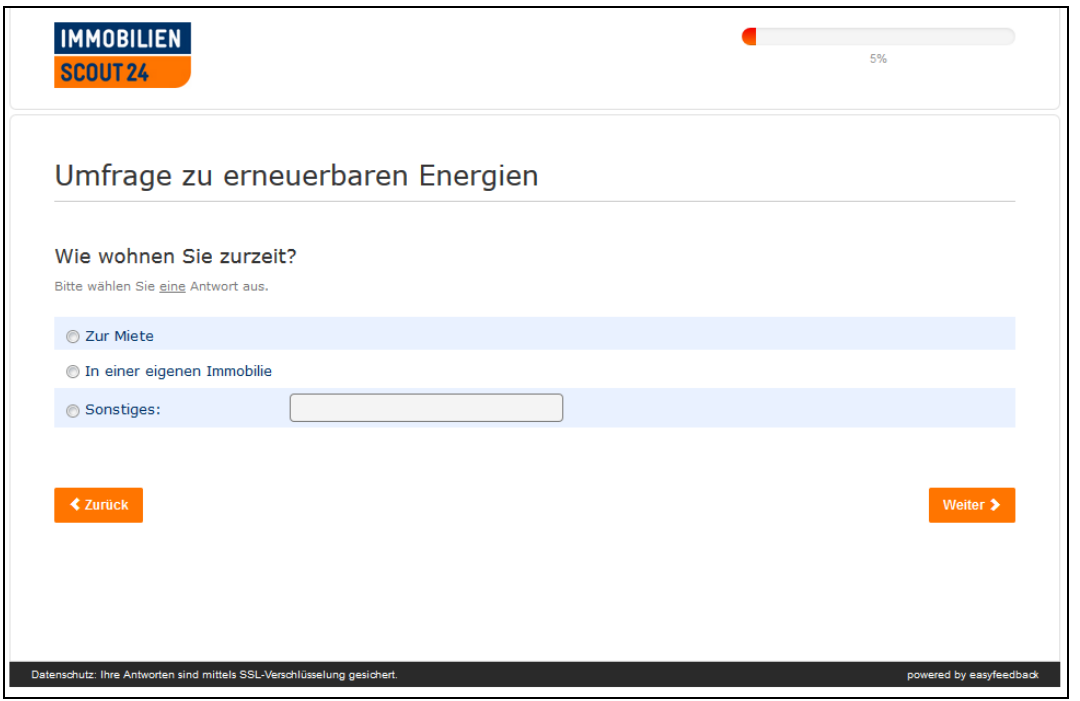
Figure A3. Screenshot of Questionnaire Page 2.